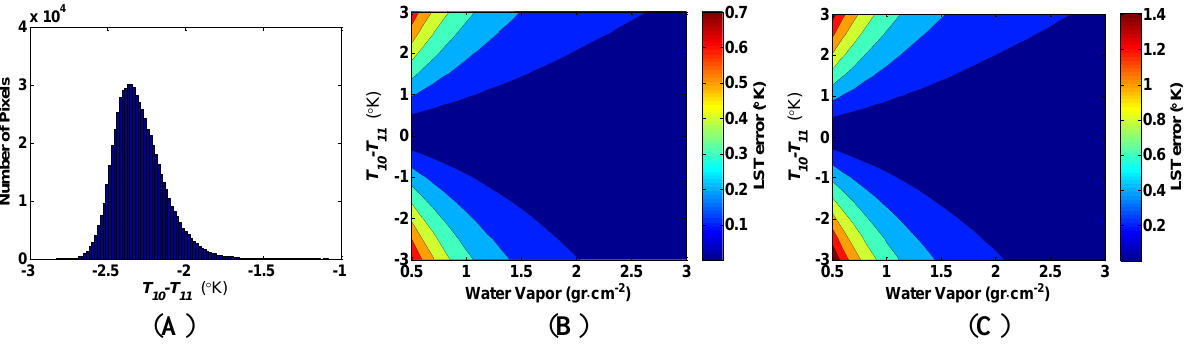
Figure 3. ( A ) Histogram of T image acquired on 30 June 2013, path 41 row 206; ( B ) The increase in land surface temperature (LST) error (°K) as a result of underestimating the water vapor content in the atmospheric column by 0.1 g · cm −2 , for different T ( C ) The increase in LST error (°K) as a result of underestimating the water vapor content in the atmospheric column by 0.2 g · cm −2 under the same assumptions as in Figure